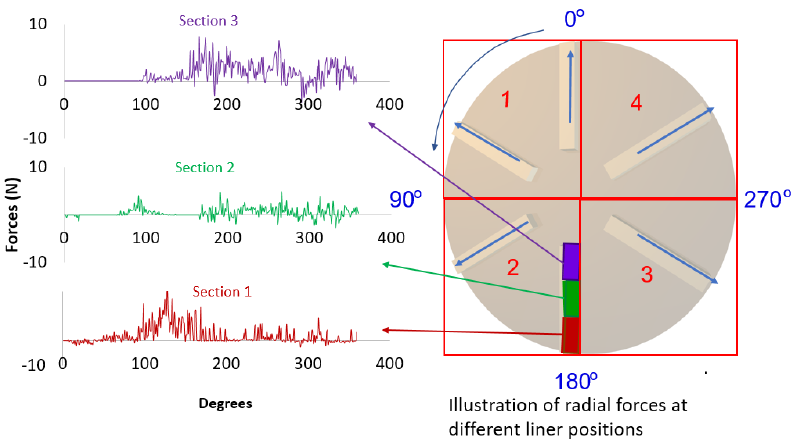
Figure 3. Radial forces acting on the 3 sections of the end lifters.